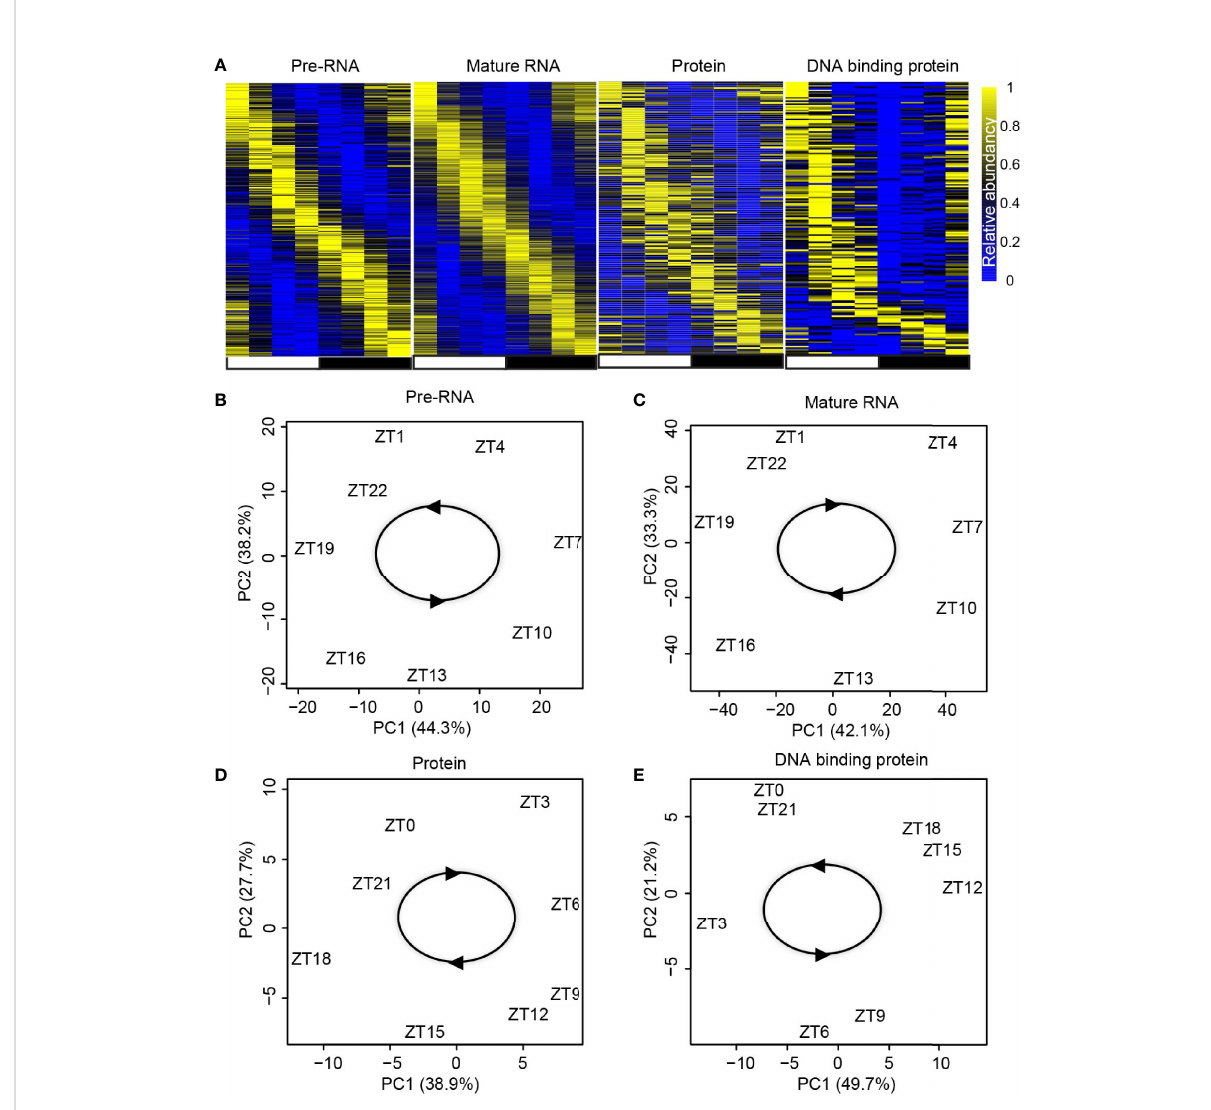
FIGURE 2 Identi fi cation of rhythmic genes in each regulatory layer. (A) Heatmap shows the expression/activity of rhythmic genes at transcription, mature RNA, protein, and DBP levels. (B – E) Principal component analysis (PCA) for the dataset from transcription (B) , mature RNA (C) , protein (D) , and DBP (E)